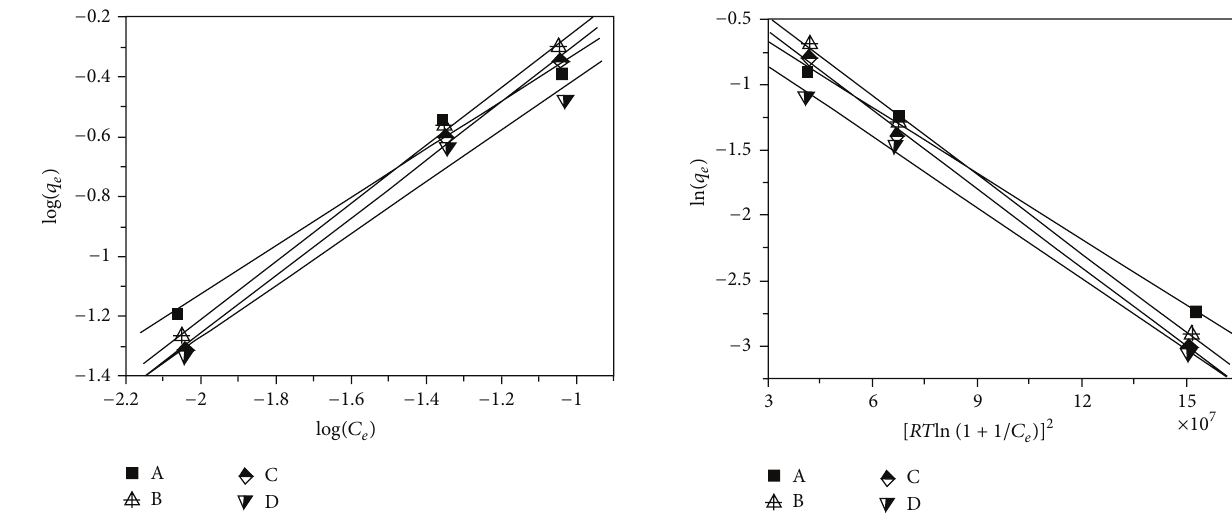
Figure3:PlotoftheFreundlichisothermmodelforlead(II)adsorp- tion on samples A–D.